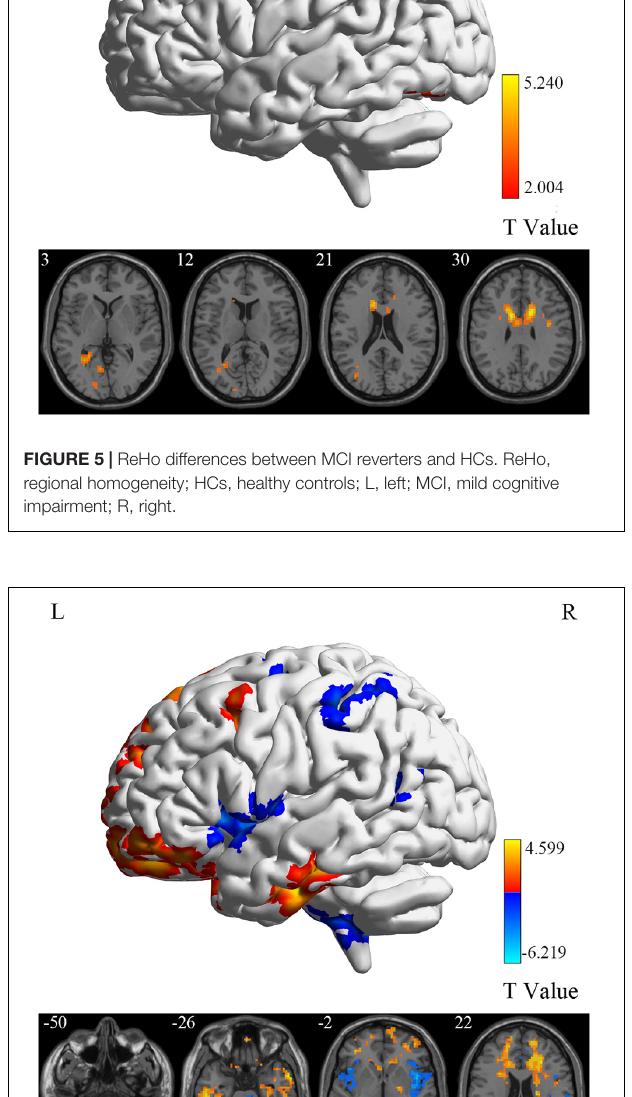
ReHo in the FFG.L, DCG.R; increased DC in the ITG.L and l SFGmed.L; decreased DC in the cerebellum_9_R and INS.L and